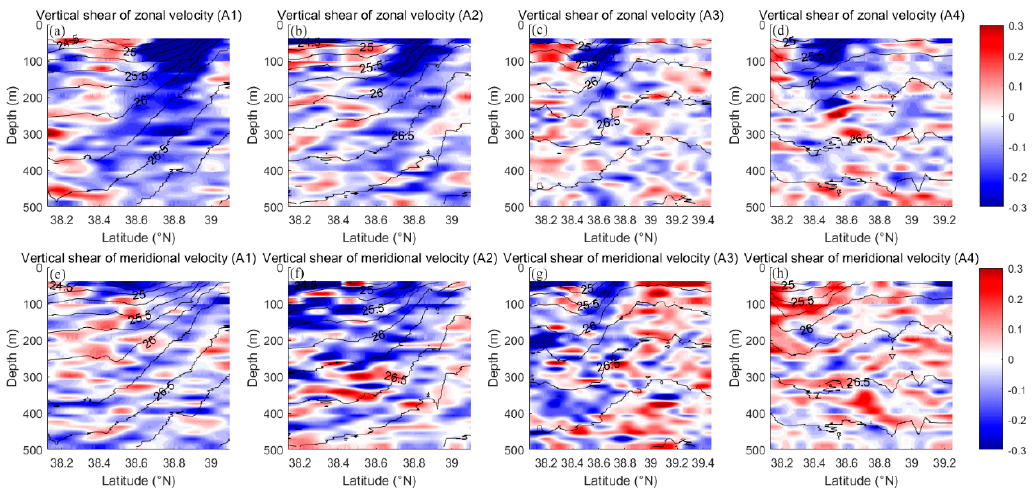
Figure 7. ( a – d ) Vertical shear of zonal velocity (shading in × 10 − 2 / s) and ( e – h ) vertical shear of meridional velocity (shading in × 10 − 2 / s) of the four sections. Contours indicate the potential density (kg / m 3 ) with 0.25 kg/m 3 intervals.